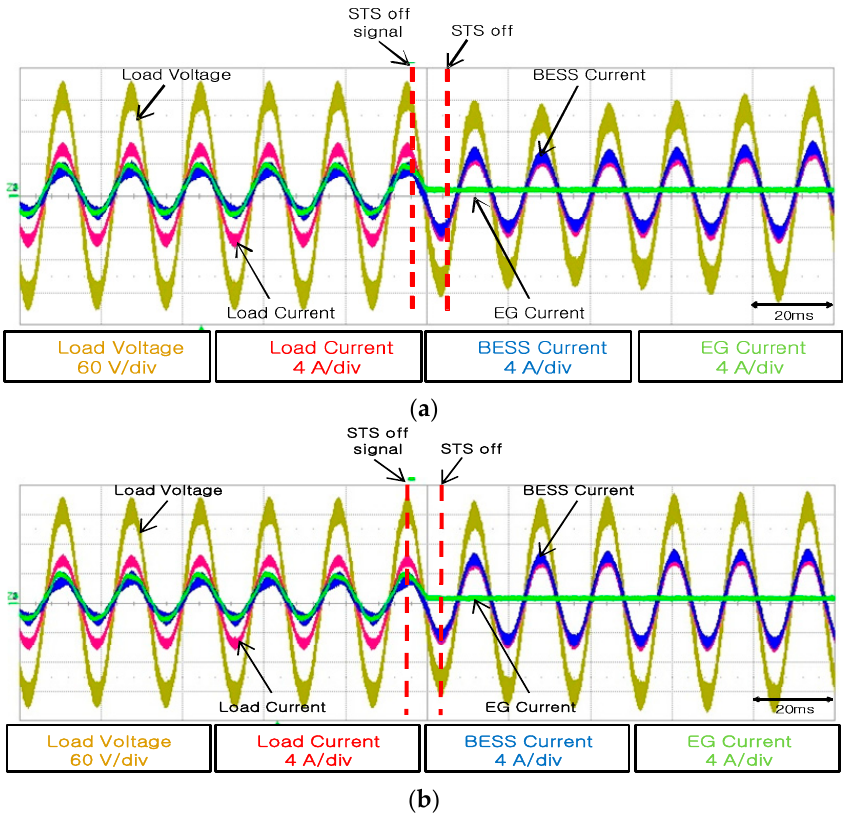
Figure 12. Mode change from current control to voltage control: ( a ) Without initial values; ( b ) With initial values.